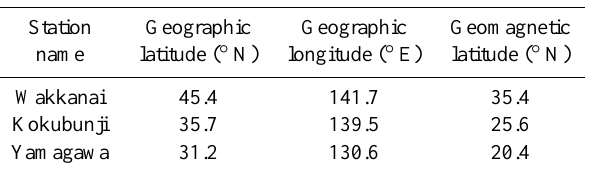
Table 1. Geographic and geomagnetic positions of the ionosondes in Japan. Station Geographic Geographic Geomagnetic latitude ( ◦